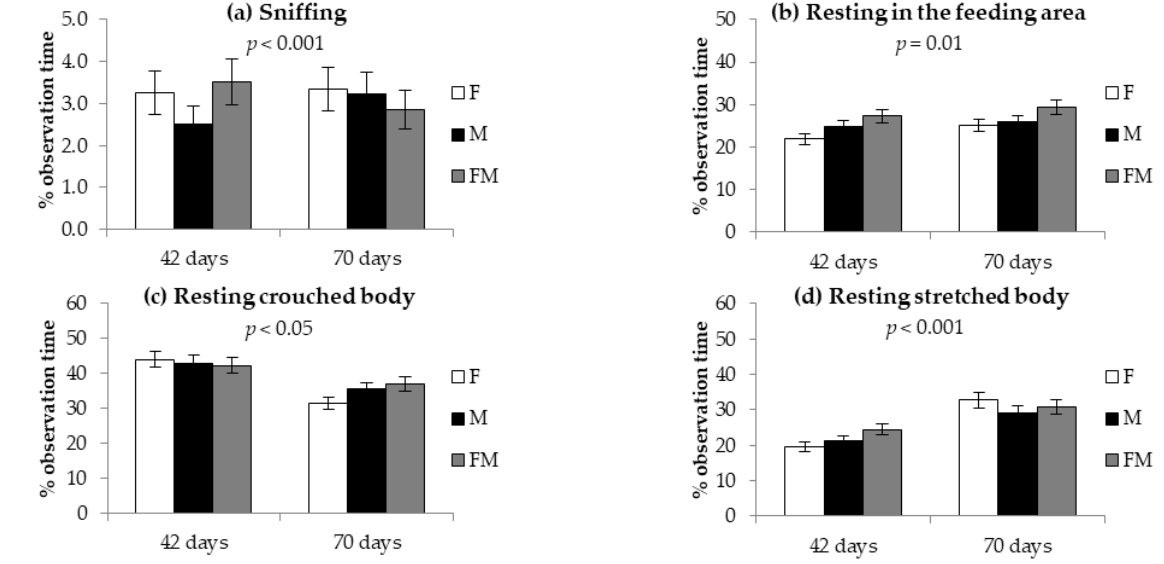
Figure 3. Time (% of observation time) spent ( a ) sniffing, ( b ) resting in the feeding area of the park, ( c ) resting with crouched body, and ( d ) resting with stretched body in growing rabbits kept in collective parks with only females (F), only males (M) or with males and females (FM) at 42 and 70 days of age (significant interactions between sex-group composition and age). Data are reported as means ± standard deviations. Table 3. Effect of the presence of gnawing hay blocks and sex-group composition age on behaviors of growing rabbits kept in collective parks during the open-field test at 64 days of age. Data are reported as the means ± standard